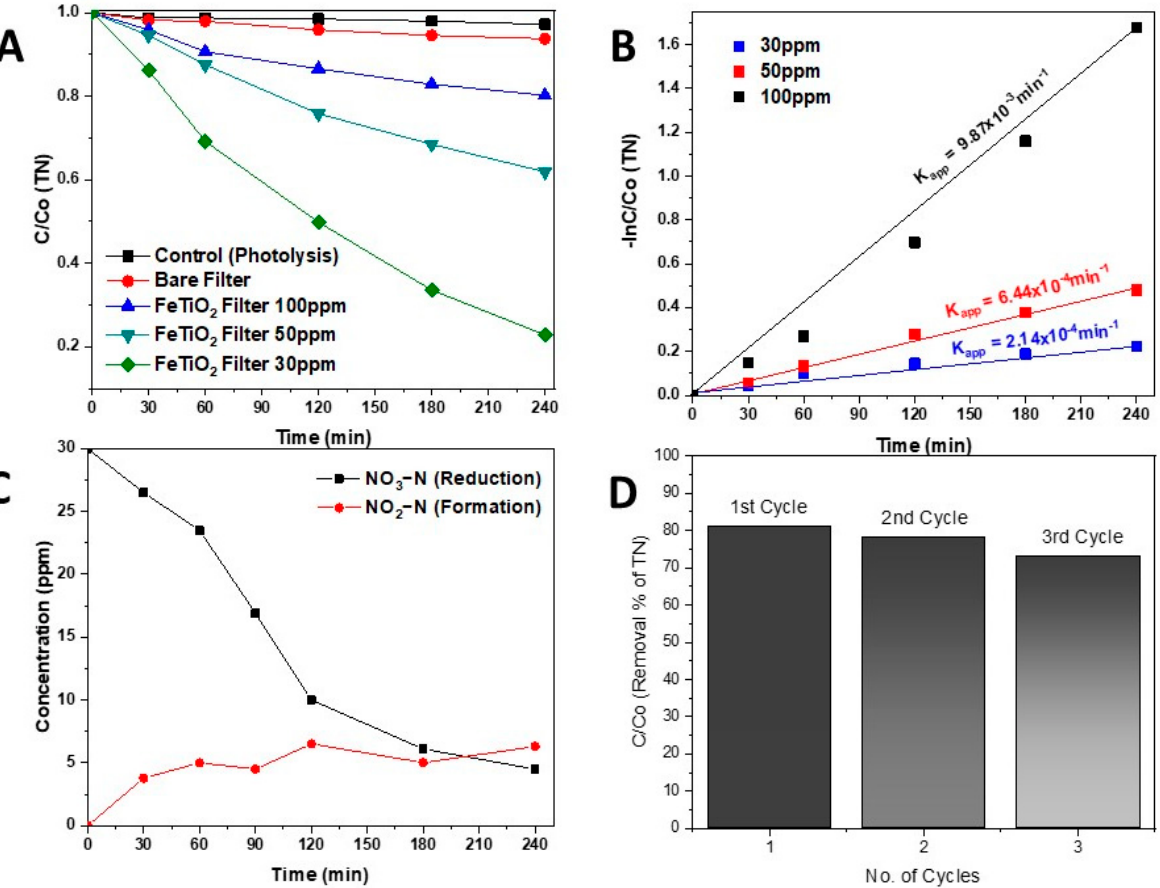
Figure 4. ( A ) Relative concentration of TN reduction of 30, 50, and 100 ppm using control, bare, and Fe-TiO 2 clay filters; ( B ) Kinetic curves with estimated kinetic apparent constant ( Kapp ) values at concentrations using Fe-TiO 2 clay filters; ( C ) NO 3 reduction and nitrite (NO 2 − ) formation kinetics at a concentration of 30 ppm NO 3 ; and ( D ) cyclic stability performance of Fe-TiO 2 clay filters at a concentration of 30 ppm NO 3 .